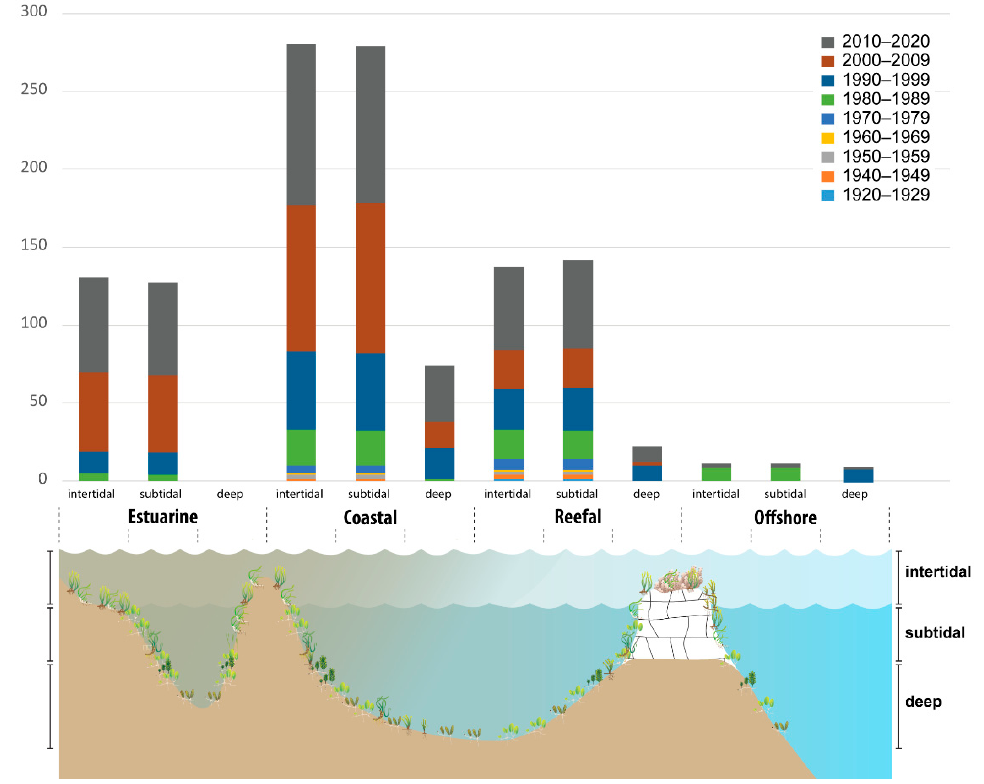
Figure 7. Number of events mapping seagrass meadow extent in each of the seagrass habitats across the GBRWHA over the last century (1920–2020). Conceptual diagram based on Udy et al. [25]. Source data are provided in Table S1.